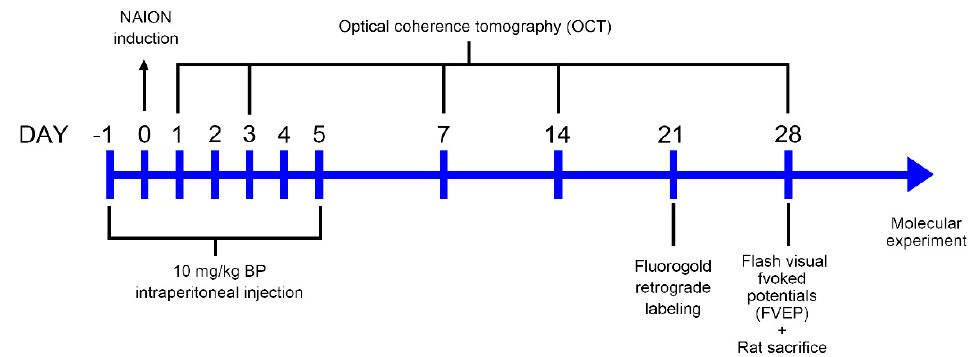
Figure 9. Timeline of the experimental process.